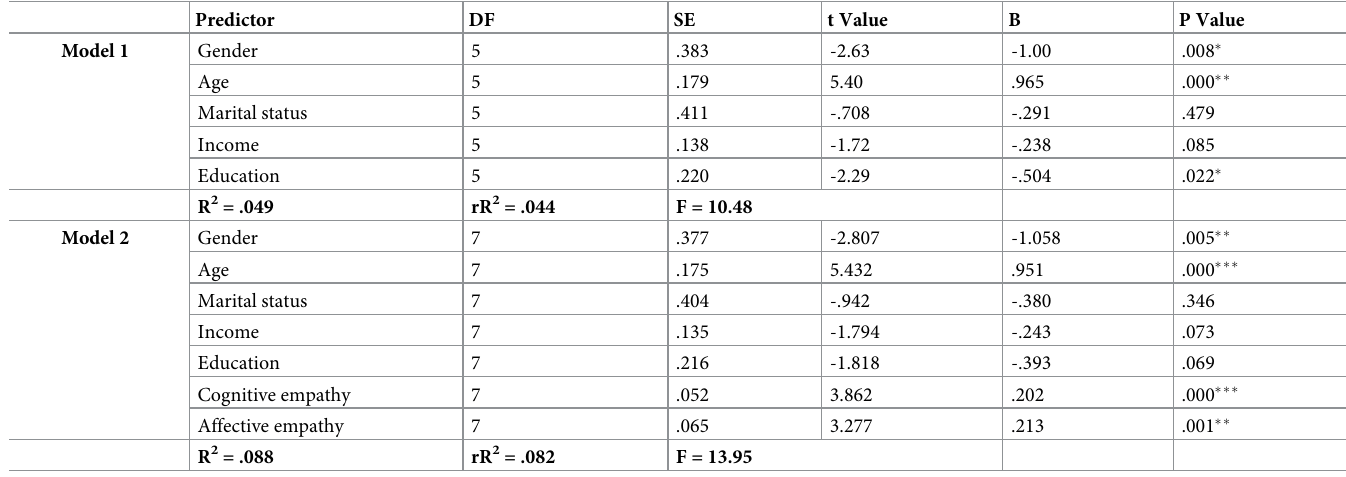
Table 3. Predictors of COVID-19 related stigma (N = 1,074).